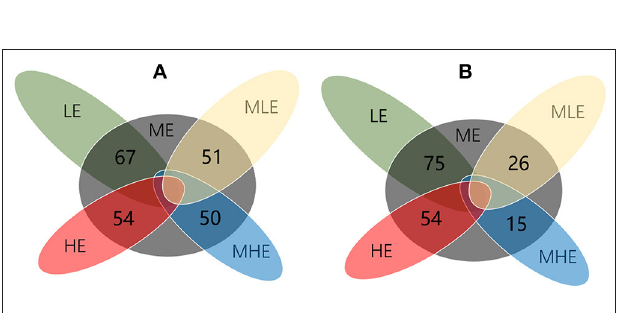
PLS-DA in the positive and negative modes are provided in Supplementary Figures 2, 3 ,